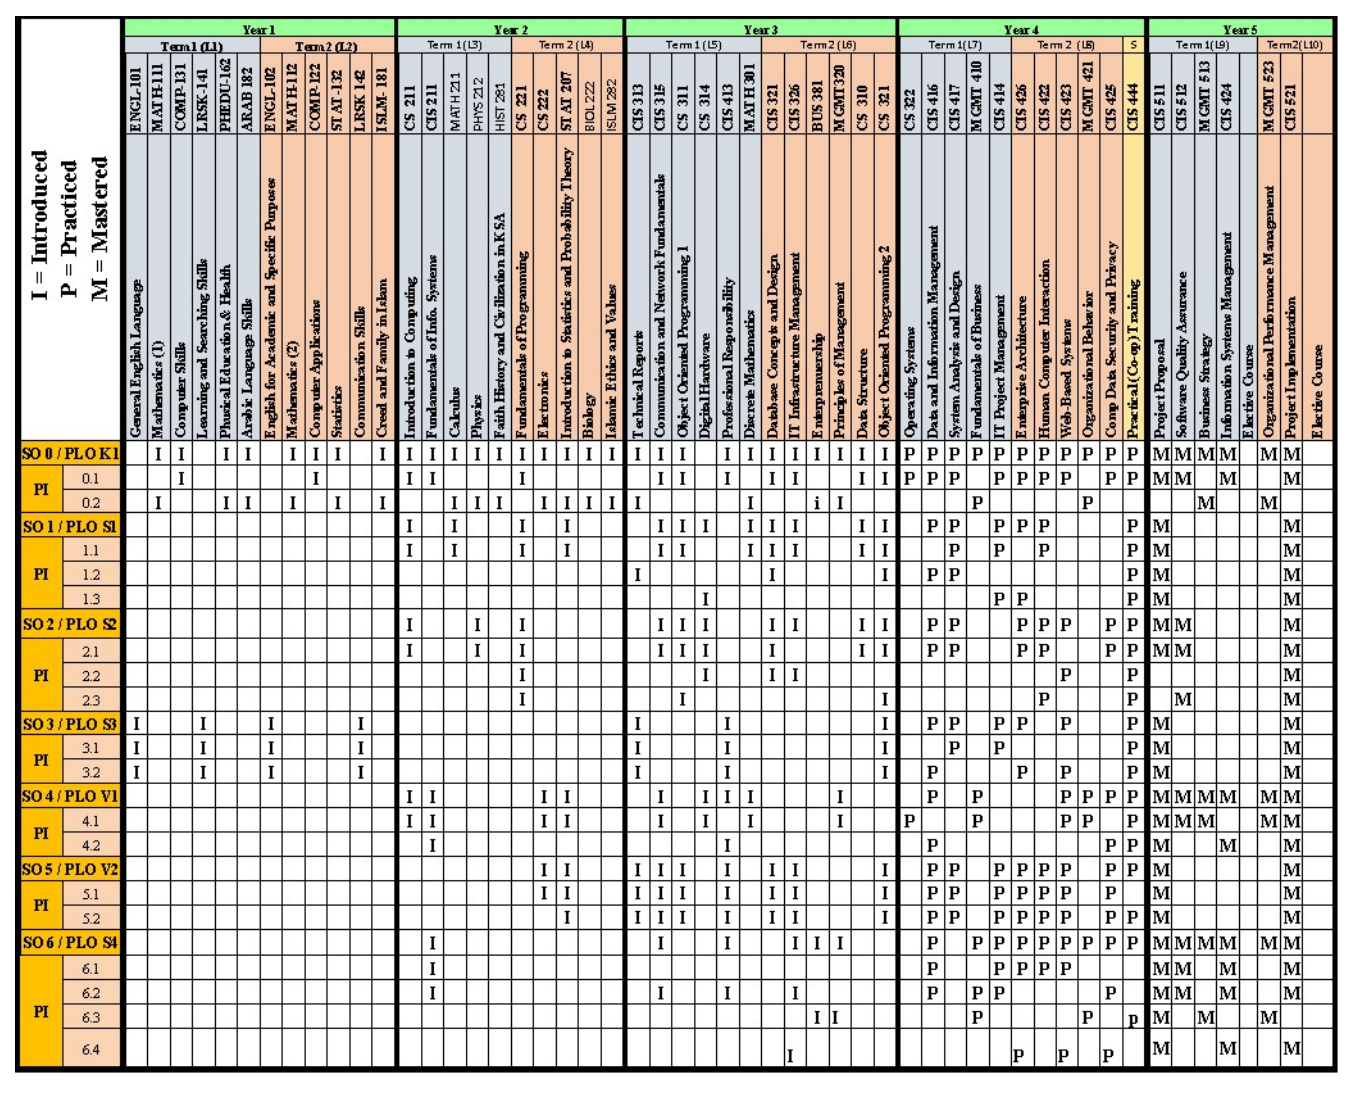
Figure A1. Unified Program Mapping.